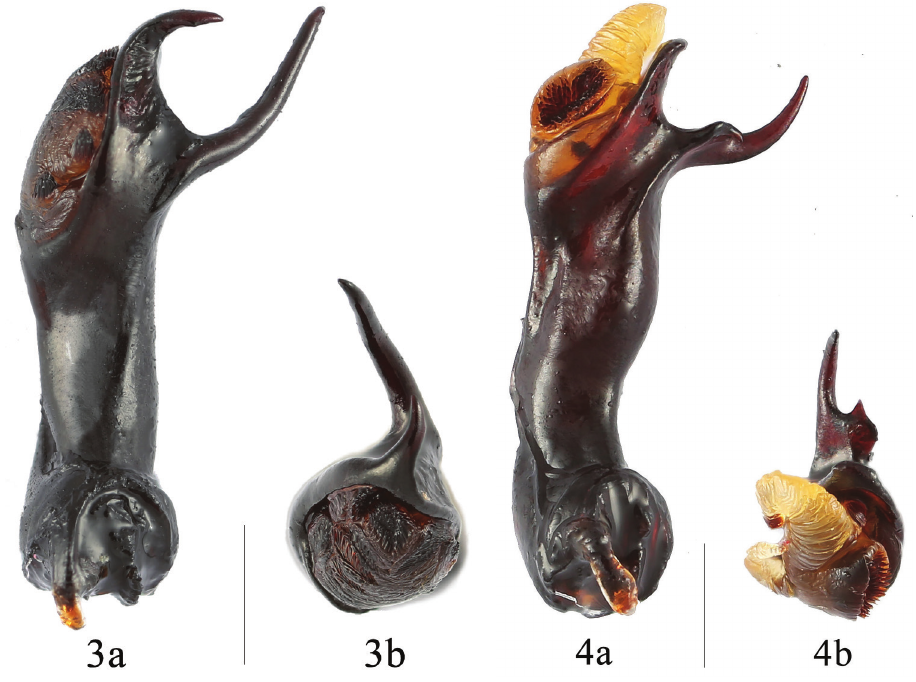
Figures 3–4. Aedeagi. 3 E. falcifasciatus sp. n. 4 E. qiujianyuei sp. n. Abbreviations: a lateral view b apical view. Scale bars 1